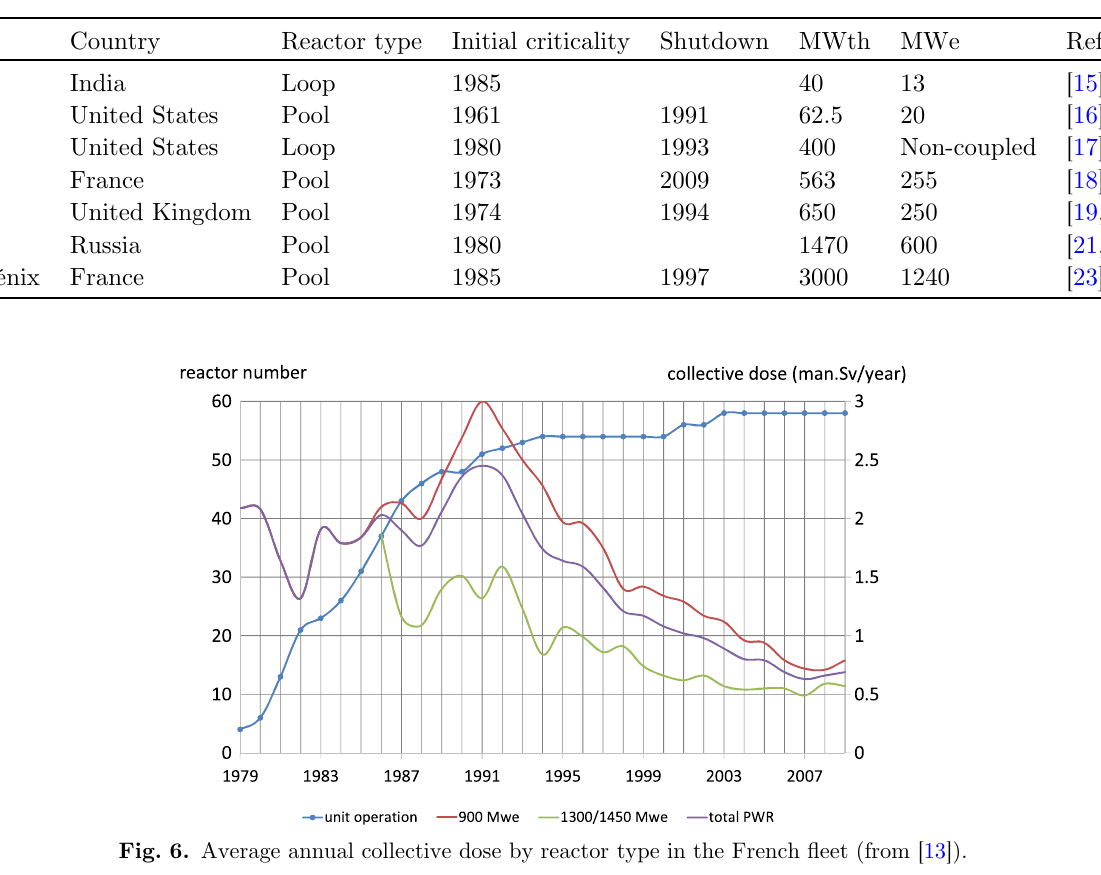
Table 1. Sodium-cooled fast reactors taken into